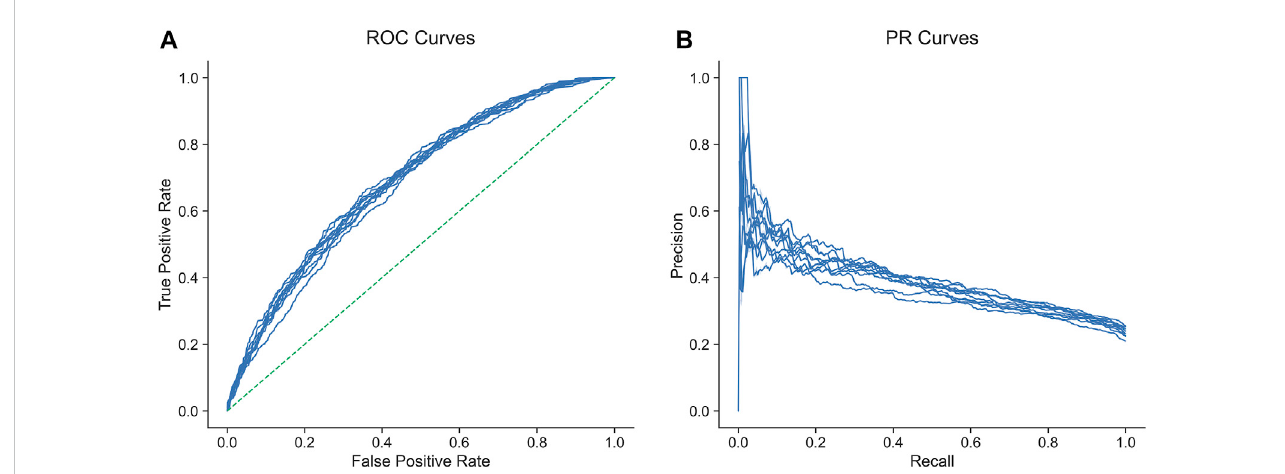
FIGURE 3 Receiver operating characteristic (A) and precision-recall (B) curves of ten cross-validated random forest models for the prediction of involvement in phenotypic abnormality from total somatic mutations, gene age, and genomic/epigenomic